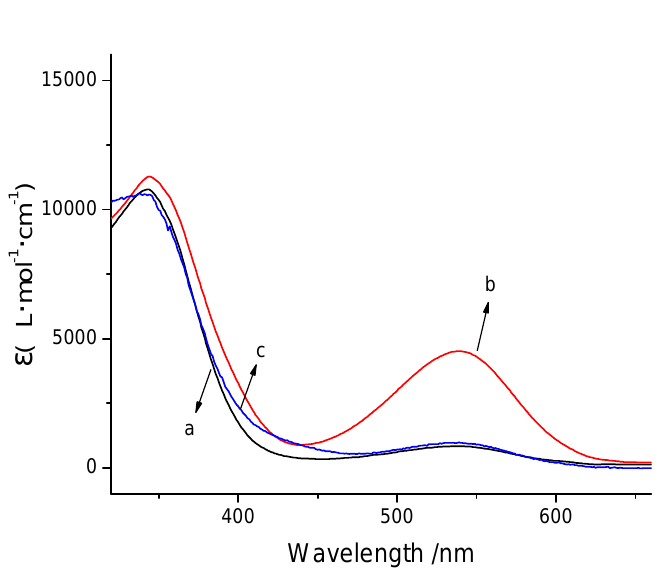
Figure 1. Absorbance spectra of spiropyran (1×10  5 mol/L, 298 K, MeCN/H at 365 nm light from 15 s to 5400 s.